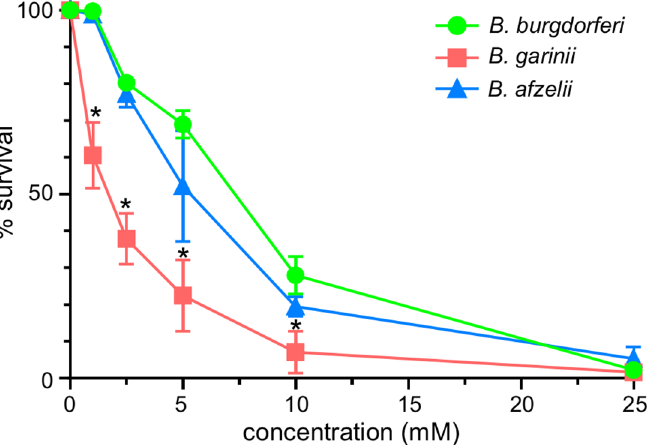
Fig 3. Survival to tert -butylhydroperoxide. Early stationary phase cultures were incubated for 1.5h with 0, 1, 2.5, 5, 10 and 25 mM of tert -butylhydroperoxide. Survival was determined by plating on BSK-II. Plates were incubated at 34˚C under microaerobic condition for 7-14d to allow enumeration of CFUs. Untreated samples were used to standardize survival (100%). Data represent means ± standard deviation. An asterisk indicates a significant difference compared to B . burgdorfe ri B31 using a one-way ANOVA where p < 0.05.